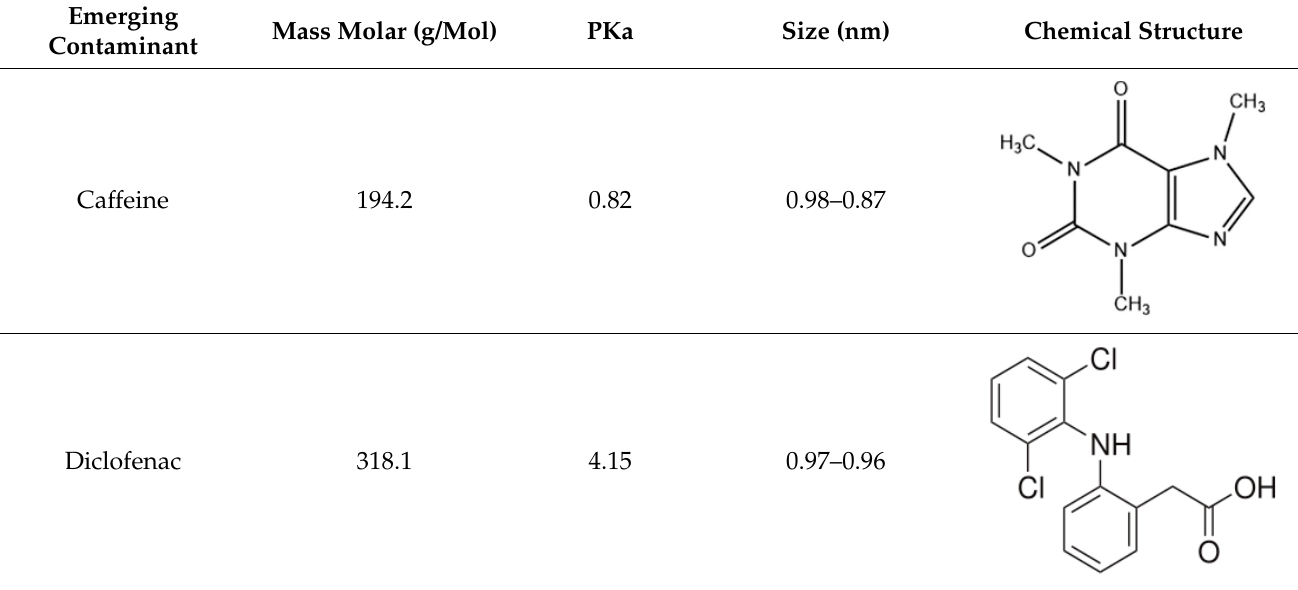
Figure 1. Initial samples of argan fruit and the process of preparation of activated Table 2. Properties and chemical structures of the contaminants studied. Table 2. Properties and chemical structures of the contaminants studied.